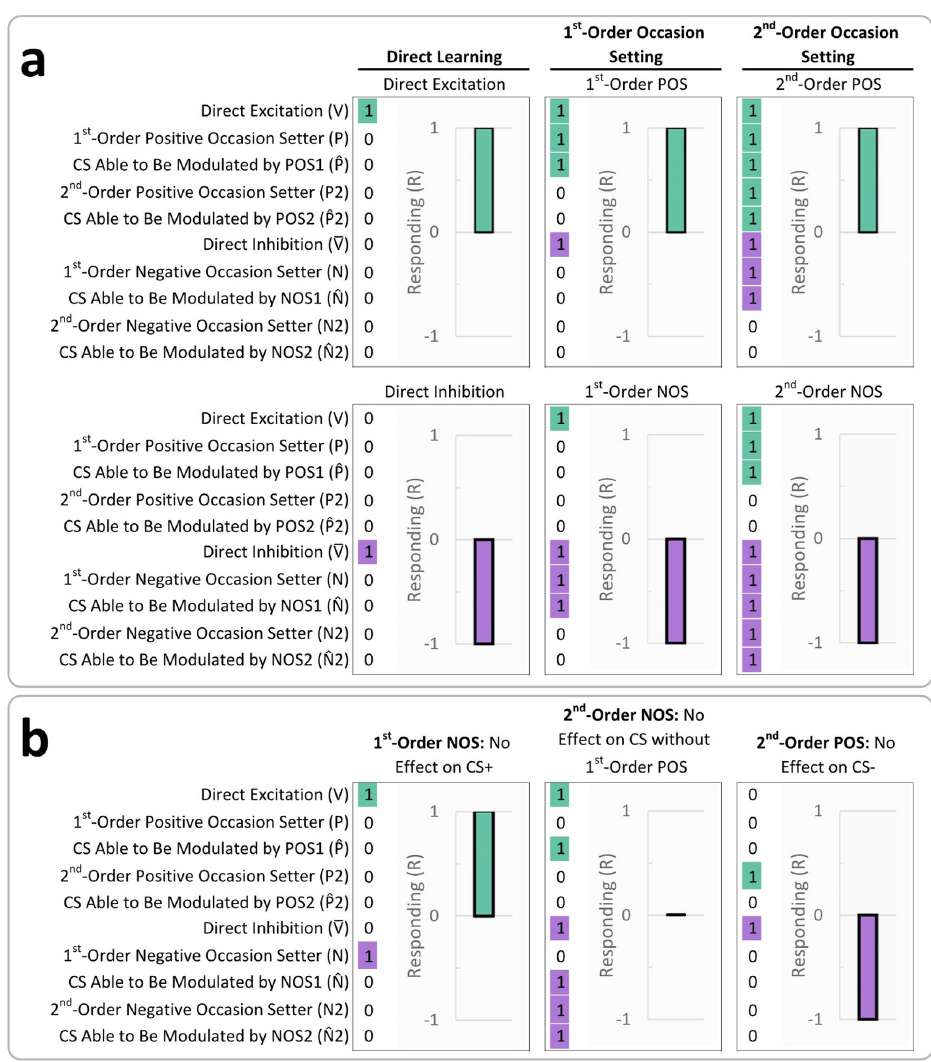
Fig 6. Examples of Formula Inputs and Outputs. The formula variables (e.g., V, � V , P) represent presence/absence of stimuli on a hypothetical trial and their training history. Bar graphs indicate predicted responding (i.e., R) to CS based on its training history and presence/absence of occasion setters. Left column provides names of formula variables. Across each row from these variables are values of 0 or 1, corresponding to the values of the variables’ names on the left. The values used by each figure are located in a column directly to the left of each figure. For example, the top-left figure shows a CS with 1 for direct excitation (V) and 0 for all other values (i.e., this is a CS+). POS = positive occasion setting; NOS = negative occasion setting. Excitation is color-coded as teal; inhibition is color-coded as purple. a) Examples of Direct Associative Learning and Successful Occasion Setting. We arranged inputs and outputs in a 2x3 grid, where the first column shows direct learning, the second column shows successful 1 st -order occasion setting, and the third column shows successful 2 nd -order occasion setting. First row shows excitatory responses, and second row shows inhibitory responses. b) Examples of Unsuccessful Occasion Setting. In bottom-left figure, we provide an example to demonstrate that 1 st -order occasion setters do not affect responding if either direct excitation or direct inhibition are 0 (in our example, a 1 st -order negative occasion setter does not affect a CS+, whose direct inhibition = 0). Congruently, 2 nd -order occasion setters do not affect responding if any of the following are 0: direct excitation, direct inhibition, 1 st -order positive occasion setting, or 1 st -order negative occasion setting. As examples, in the bottom-middle plot, we show a 2 nd -order negative occasion setter will not affect a CS unless an ambiguous 1 st - order occasion setter is present (i.e., no 1 st -order occasion setter is present, so P and N = 0). In our bottom-right plot, a 2 nd -order positive occasion setter will not affect a CS- for multiple reasons, such as direct excitation = 0 and having no 1 st -order occasion setter present (i.e., P and N =